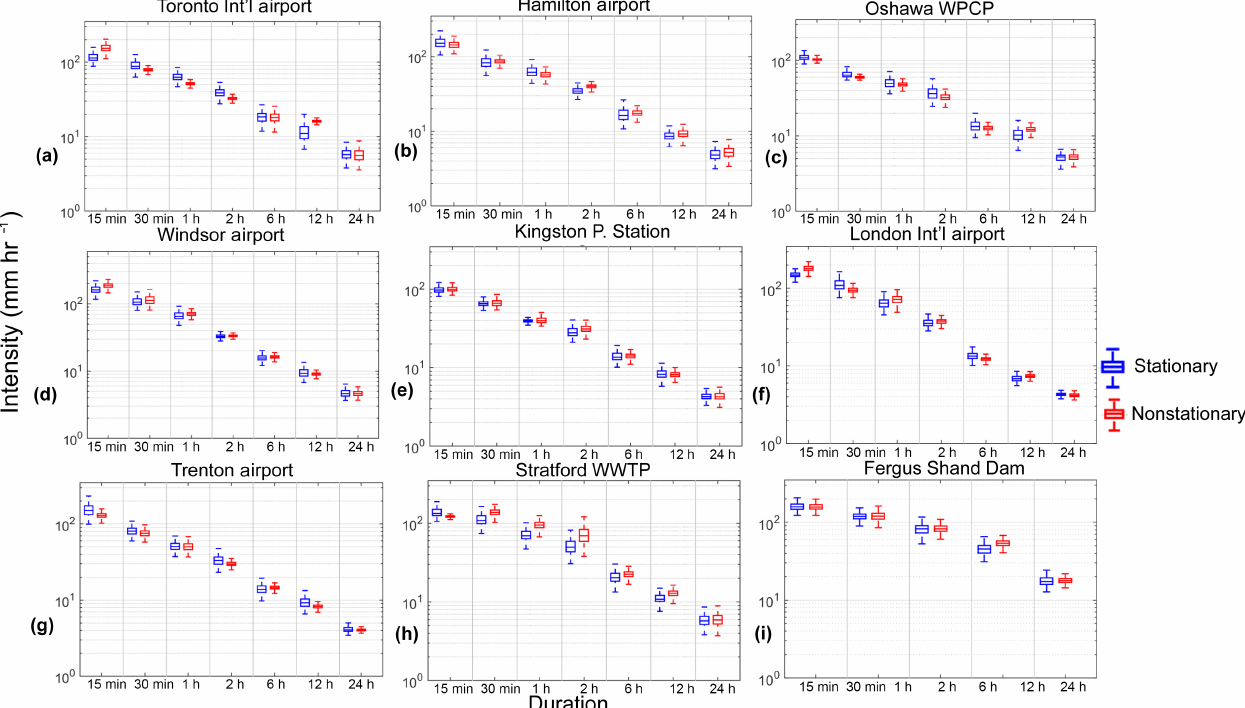
Figure 4. DSI estimates of the median (horizontal line within the box plot) and 95% credible intervals for 100-year return periods of stationary vs. nonstationary models across nine sites (a–i) . The boxplots indicate the uncertainty in estimated DSI using Bayesian